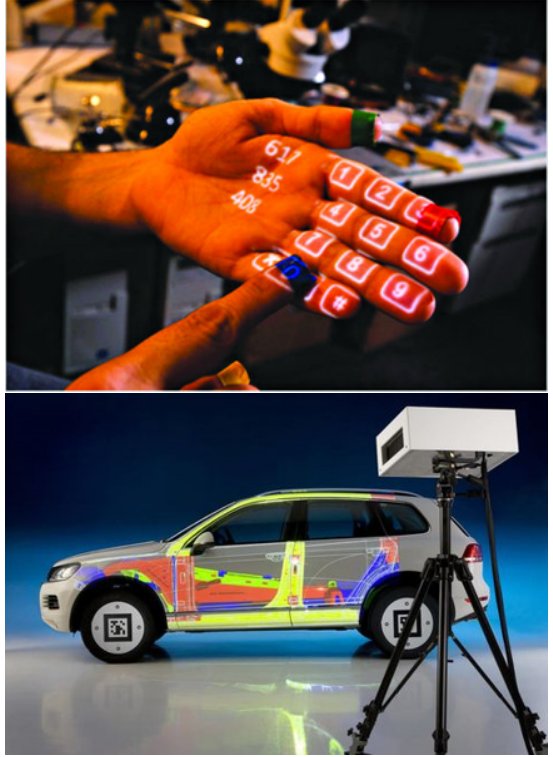
Figure 1: Example of a projection type of virtual reality [14,